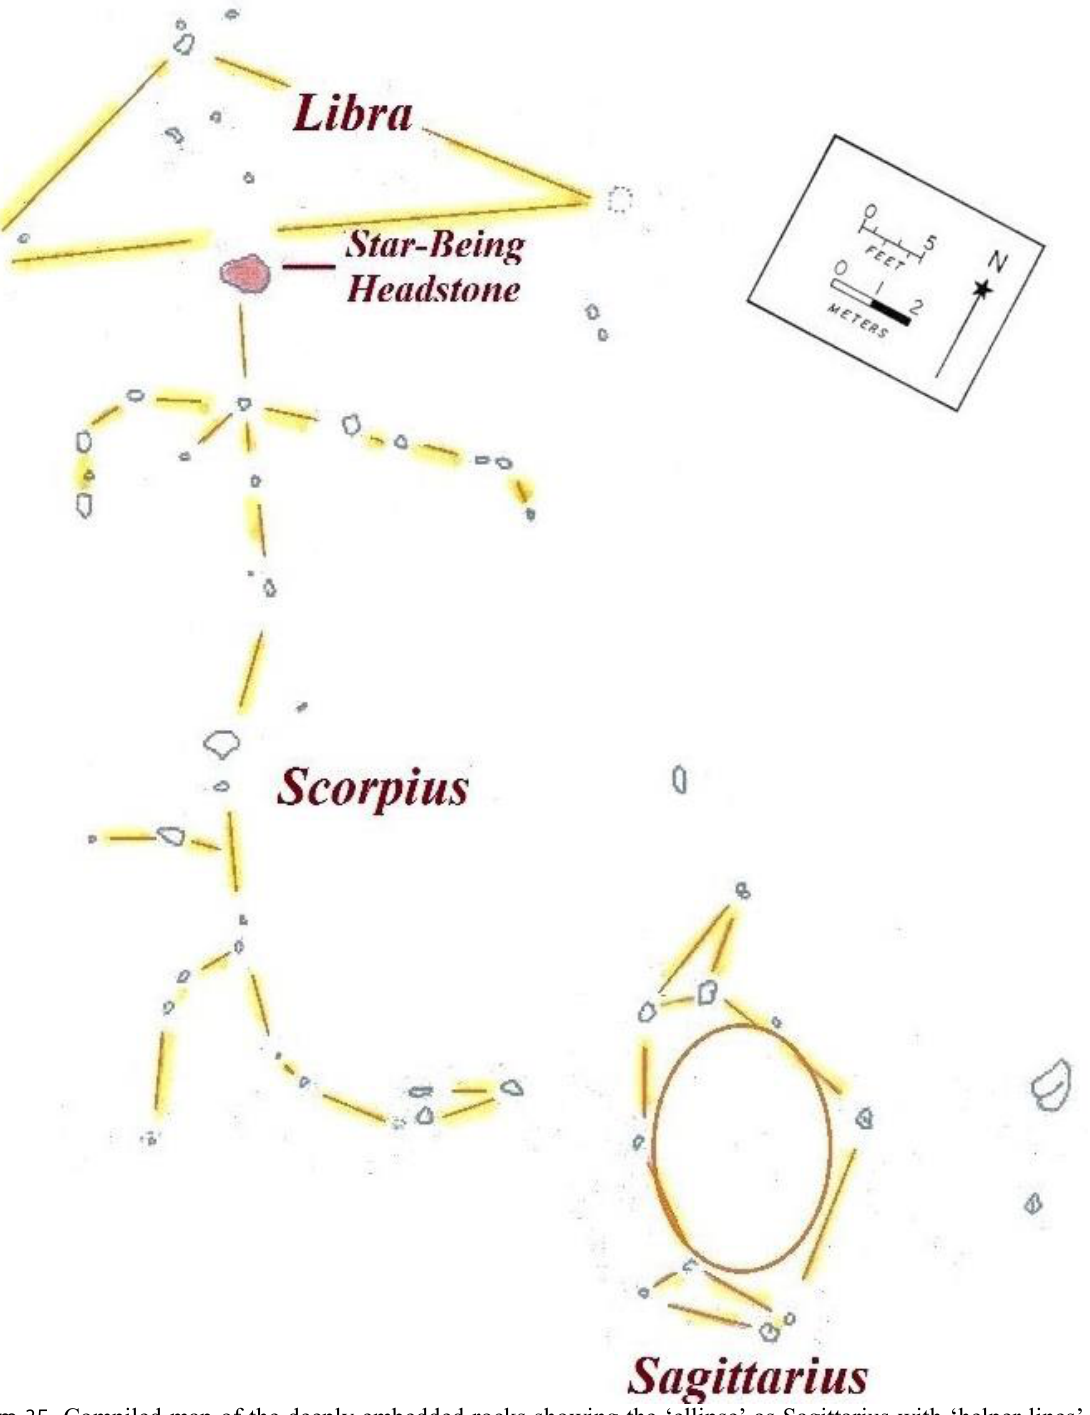
Figure 35. Compiled map of the deeply embedded rocks showing the ‘ellipse’ as Sagittarius with ‘helper lines’ added and the Star-Being petroform designated as Scorpius and Libra (see Figure